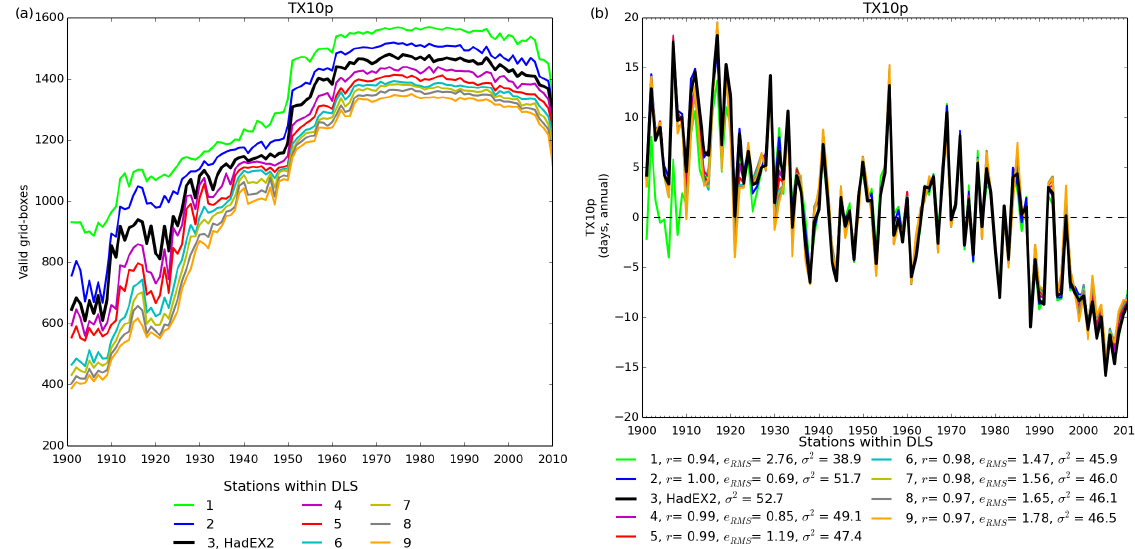
Figure 4. (a) The number of non-missing grid boxes for TX10p ( T max < 10th percentile) for the different numbers of stations required within a DLS of the grid box centre. All grid boxes with sufficient stations are shown in the coverage series. (b) The time series for global average TX10p for the different numbers of stations required within a DLS of the grid box centre, given the overall 90% completeness requirement. All choices have been centered relative to the climatology period 1961-1990, reducing the spread during this time.